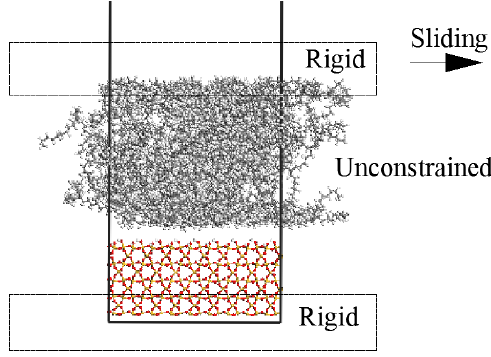
Figure 6. The representation of PE(76 – 40)/S interface model with the imposed rigid parts in the shear process.